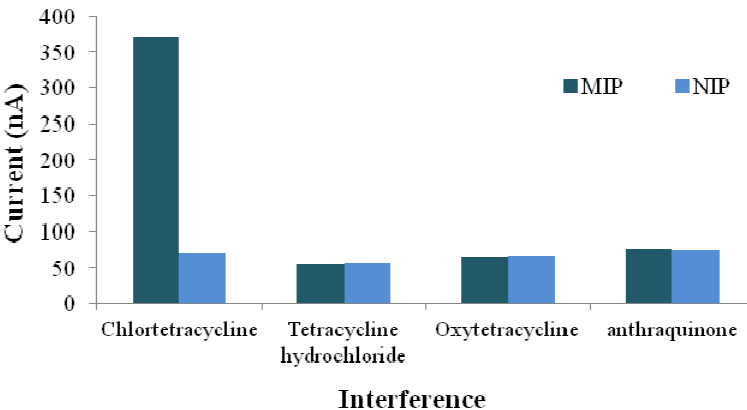
Figure 4. Current responses of the chlortetracycline-imprinted and non-imprinted polymer (NIP) for different analytes, adopted from